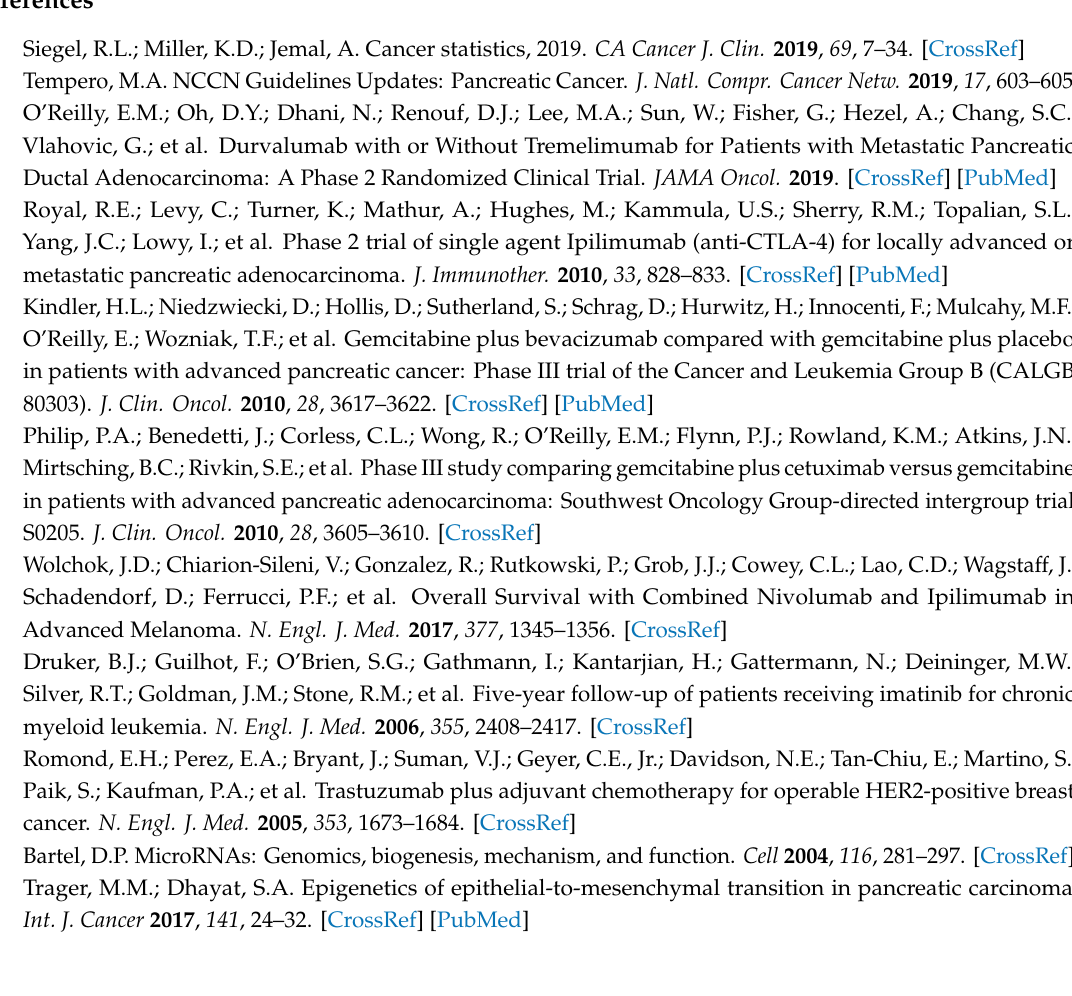
Table S1: Distribution of histopathologic characteristics of PDAC patients across UICC tumor stages; Table S2: Di ff erential expression of miR-200b and miR-200c in serum exosomes; Figure S1: Whole western blots; Figure S2: ROC curve analysis of miR panel + CA.19-9 to di ff erentiate between UICC tumor